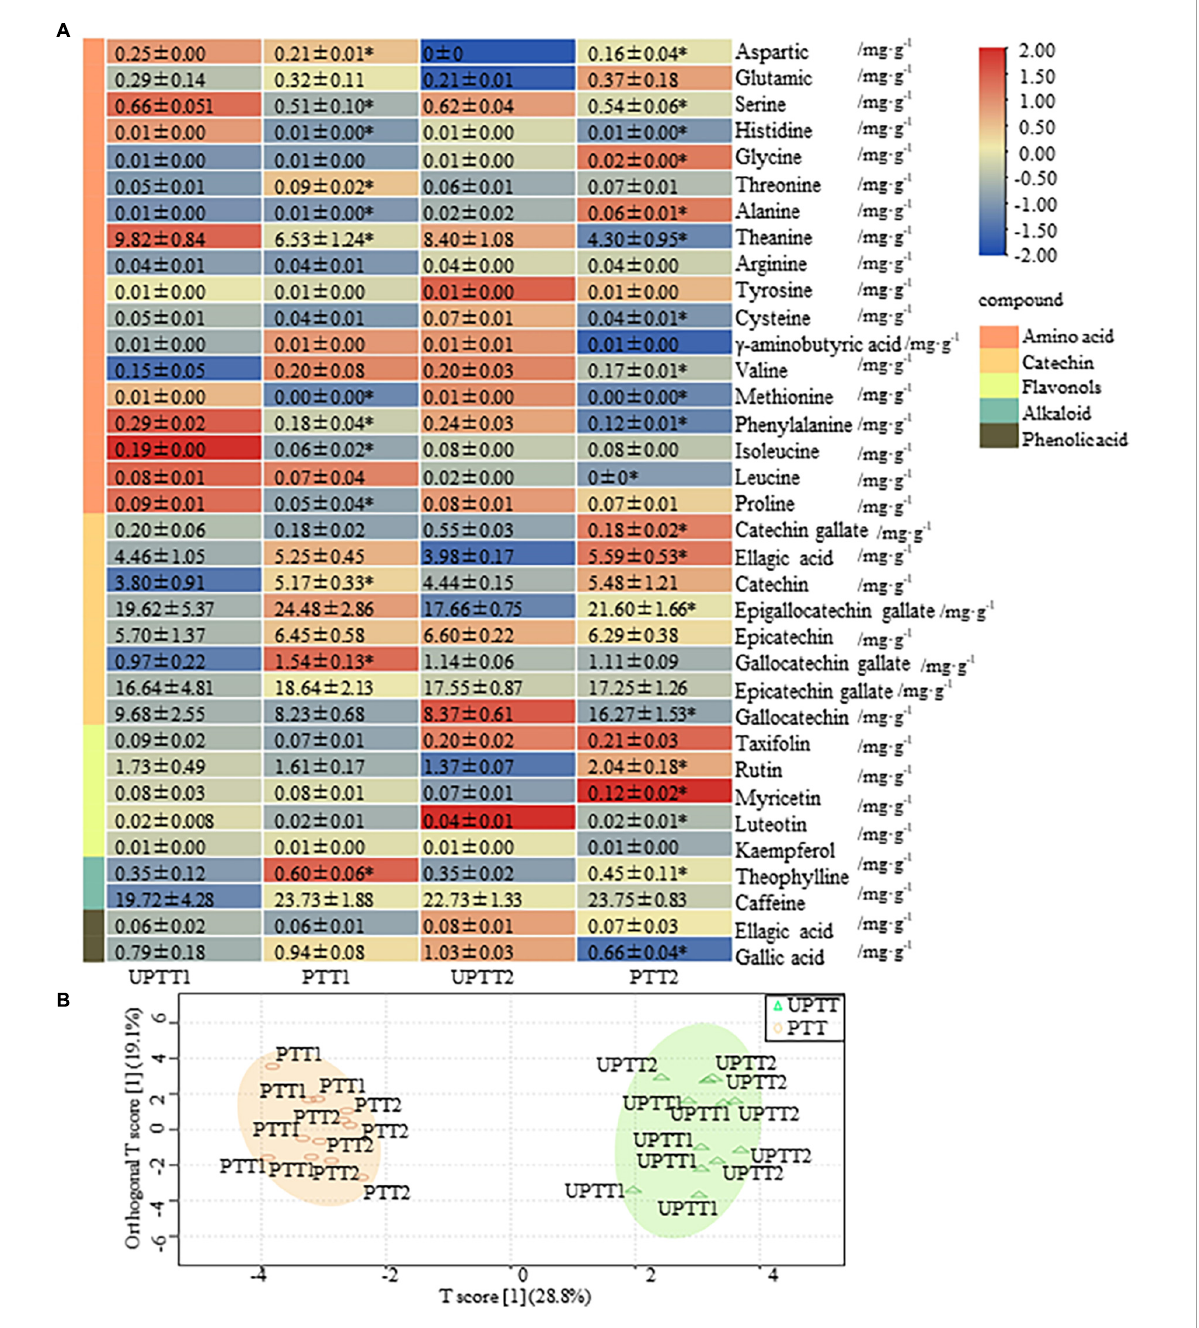
FIGURE3 Levels of 36 characteristic chemical compounds (amino acids, catechins, flavonols, alkaloids, and phenolic acid) in tea leaves. OPLS-DA-based levels of 36 characteristic chemical compounds in pruned tea tree (PTT) and unpruned tea tree (UPTT) (unit: mg/g) (A) ; Compounds detected by high-performance liquid chromatography (HPLC) (B)